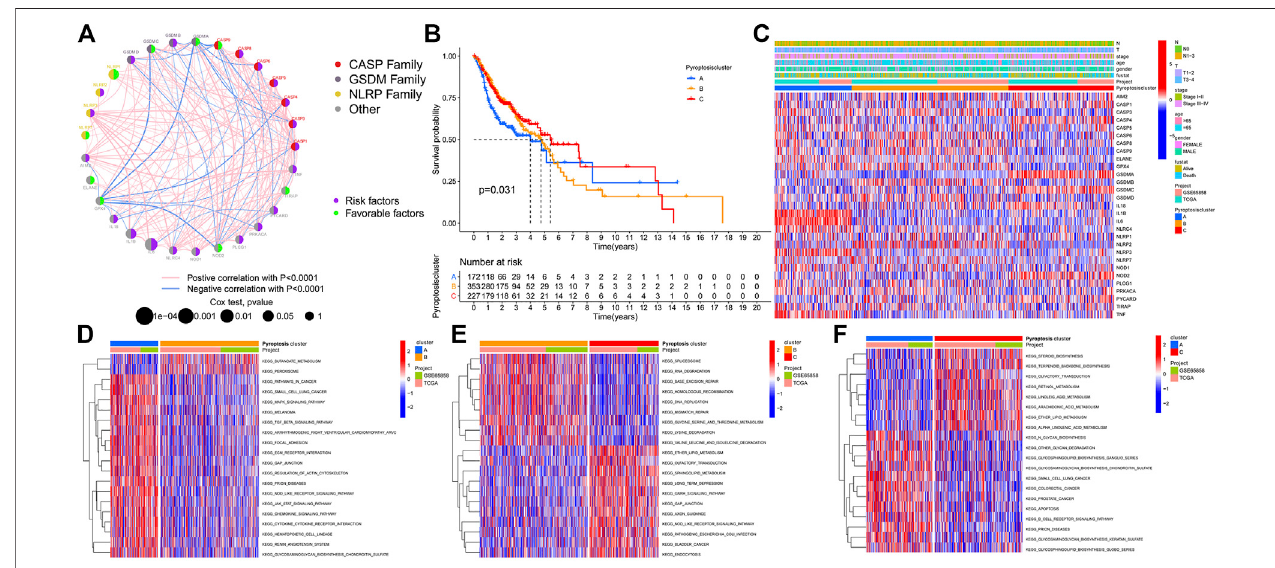
FIGURE 2 | Pyroptosis patterns and biological function in HNSCC. (A) . Comprehensive landscape of 33 PRG gene interactions, regulator relation, and their prognosis for HNSCC patients. (B) . Cluster-B model indicated a particularly outstanding survival bene fi t. (C) . Heatmap for the association between PRGs and clinicopathologicalmanifestations. (D) .PyroptosisCluster-Abiologicalfunction. (E) .PyroptosisCluster-Bbiologicalfunction. (F)